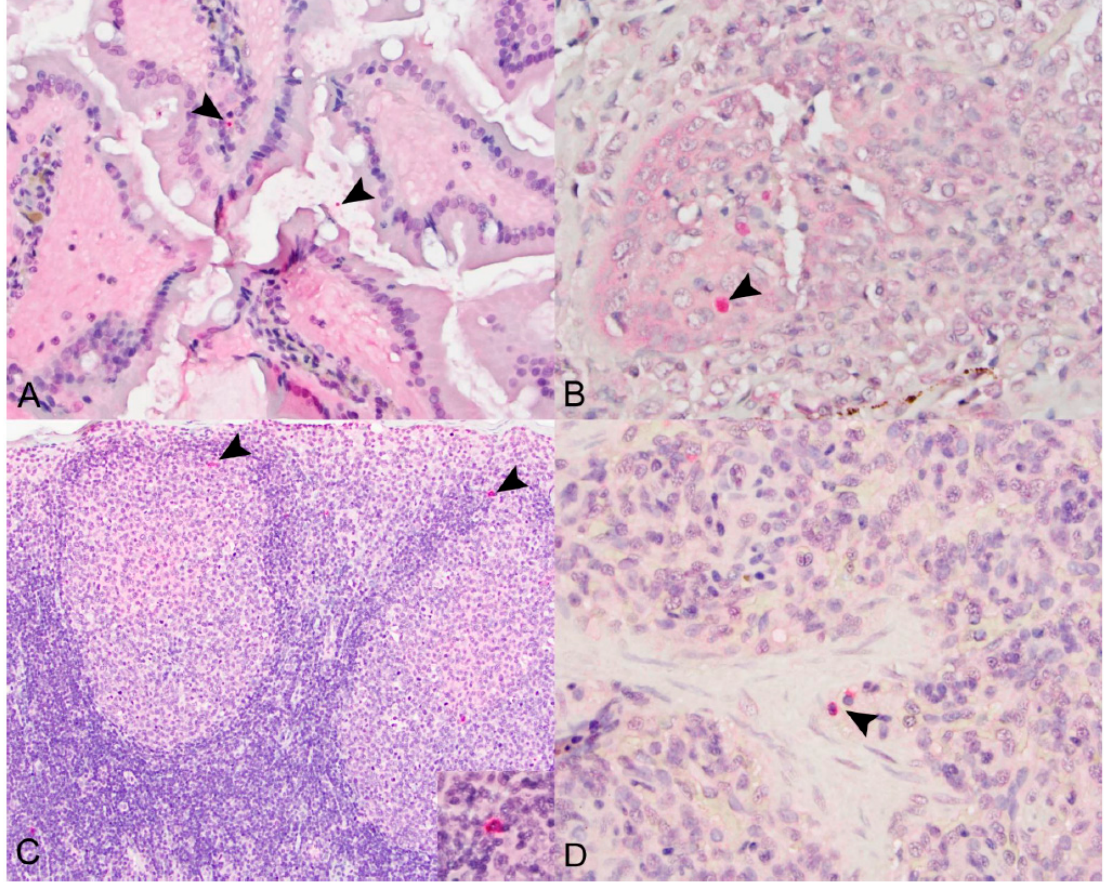
Figure 4. Immunohistochemical localization of SOSV nucleoprotein (NP) antigen in experimentally infected Egyptian rousette bats euthanized at 6, 9 or 21 DPI. ( A ) Small intestines, 21 DPI bat 289953. Granular, intracytoplasmic NP antigen is present within the villus lamina propria core and within the lumen (arrowheads). Immunohistochemical stain with Fast Red chromogen and hematoxylin counterstain; original magnification = 400 × . ( B ) Salivary gland, 6 DPI bat 284899. Multifocal cytoplasmic immunolabeling for NP antigen within the wall of an inflamed interlobular salivary duct (arrowhead). Immunohistochemical stain with Fast Red chromogen and hematoxylin counterstain; original magnification = 400 × . ( C ) Axillary lymph node, 6 DPI bat 284509. Viral nucleoprotein antigen (arrowheads) is present within the cytoplasm of histiocytic cells in the cortical germinal centers and in the paracortical regions (arrowheads and inset). Immunohistochemical stain with Fast Red chromogen and hematoxylin counterstain; original magnifications = 200 × (main image) and 600 × (inset). ( D ) Spleen, 9 DPI bat 287014. NP antigen (arrowheads) is present within the cytoplasm of few histiocytic cells in the red pulp. Immunohistochemical stain with Fast Red chromogen and hematoxylin counterstain; original magnification = 600 ×